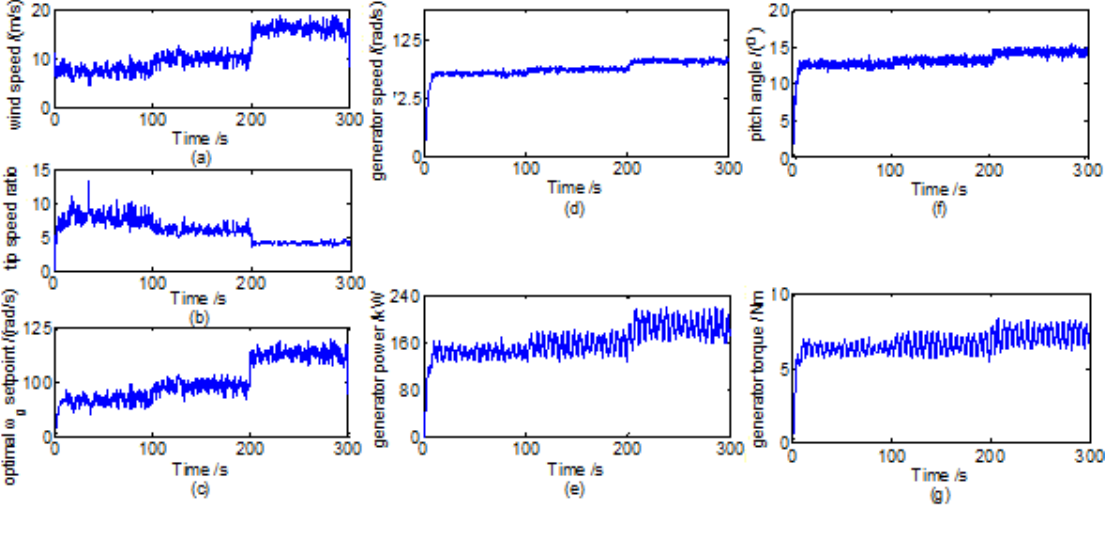
Figure 7. (cid:1834) fault tolerant control for actuators fault of WECS: ( a ) wind speed (m/s); ( b ) (cid:2998) setpiont (rad/s); ( d ) generator speed (rad/s); ( e ) generator tip speed ratio; ( c ) optimal (cid:2033) (cid:3034) power (KW); ( f ) pitch angle (°); ( g ) generator torque